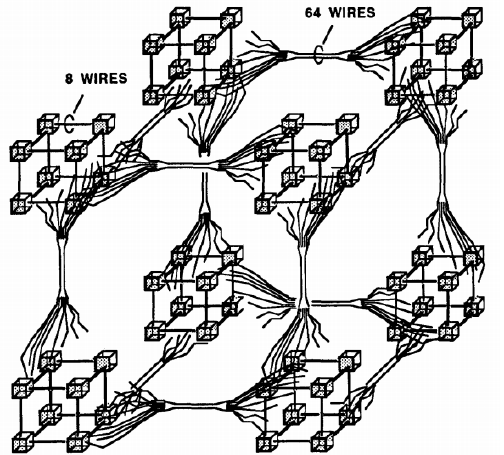
Fig. 2. Marvin Minsky’s cube-on-cube concept [ 30 ] is extrapolated from and may be a representation of the topological connectivity between neurons or neuronal